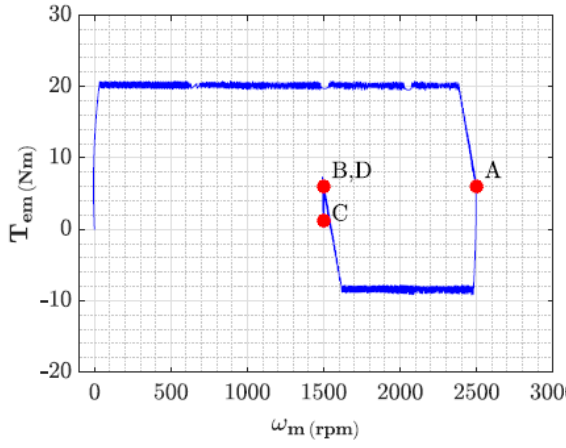
Figure 9. PI control loop, parallel configuration. Mechanical characteristics.